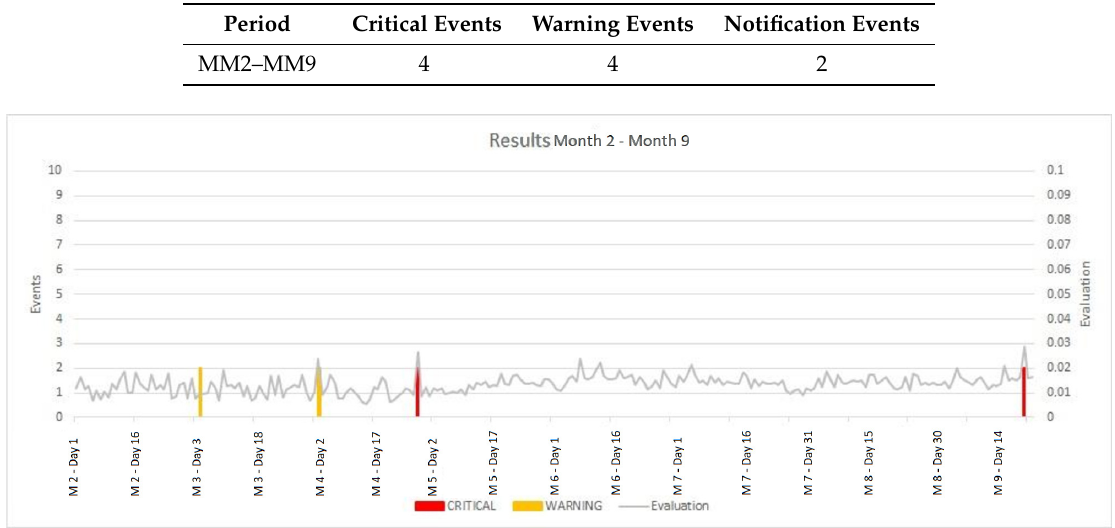
Table 7. Total monitoring period.